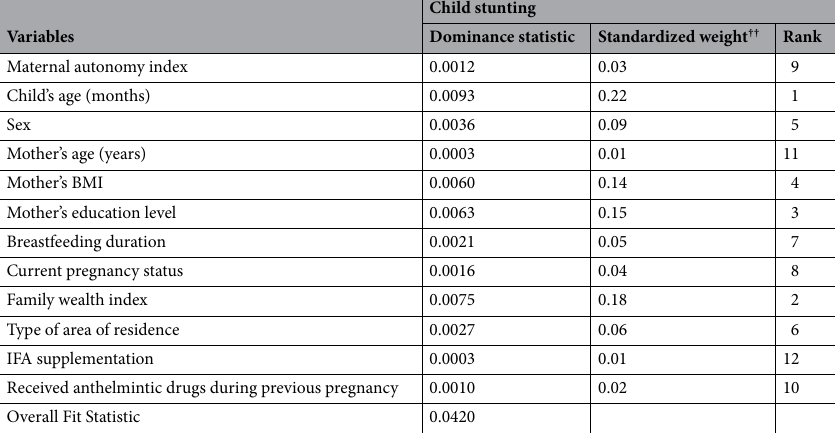
Table 4. Relative importance of the factors stunting among children aged 0–59 months in Malawi by dominance analysis ( N = 7348). †† Standardized weight is the general dominance weight from McFadden R 2 normed or standardized to be out of 100%. BMI, body mass index; IFA, iron and folic acid. Variables included in this dominance analysis are those fitted into the final model of the regression